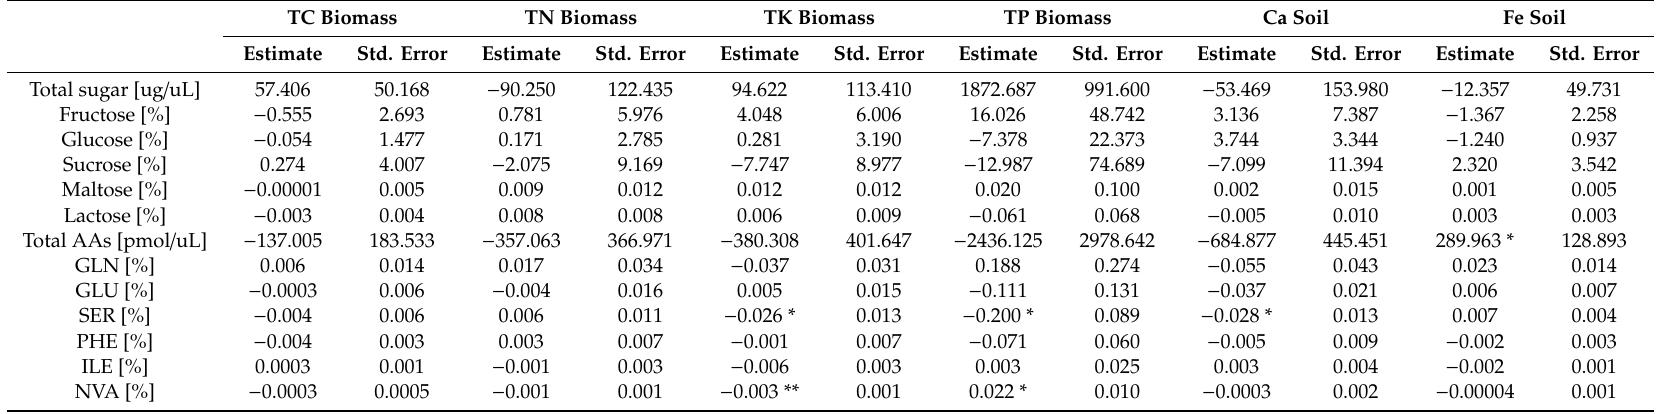
Table 3. Results of the linear mixed models performed to examine the e ff ect of biomass and soil nutrients on nectar characteristics of Polemonium caeruleum ; TC (total carbon), TN (total nitrogen), TK (total potassium), TP (total phosphorus); estimates, standard error. * 0.05 ≤ p < 0.1; ** 0.001 ≤ p < 0.05. AA (amino acids), GLN (glutamine), GLU (glutamic acid), SER (serine), ILE (isoleucine), PHE (phenylalanine), and NVA (norvaline). The size of the population was included as a random